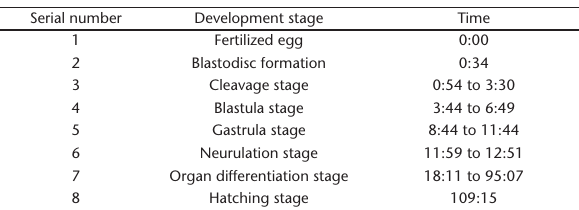
Table 1. Time and phases of embryonic development of Pseudoras- bora parva at 24 ± 1 °C.